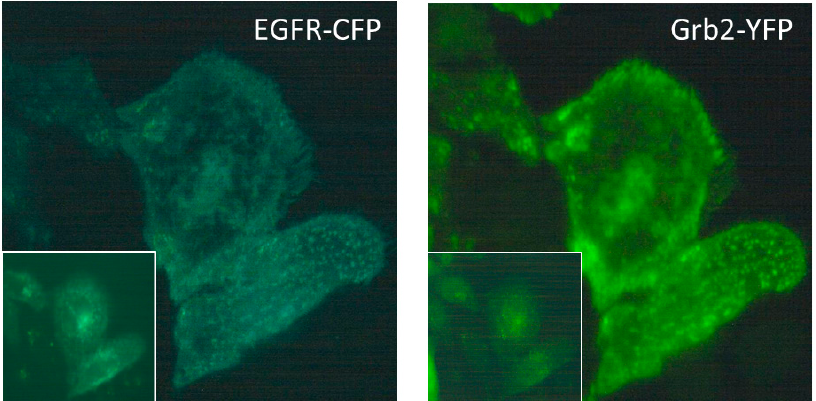
Figure 2. TIR fluorescence images of HeLa cells transfected with EGFR ‐ CFP and Grb2 ‐ YFP encoding vectors in the spectral ranges of CFP (450–490 nm) and YFP ( λ ≥ 510 nm) emission; excitation vectors in the spectral ranges of CFP (450 – 490 nm) and YFP ( λ ≥ 510 nm) emission; excitation wavelength: 420–440 nm; image size: 60 µ m × 60 µ m. Insets: fluorescence images after epi-illumination wavelength: 420 – 440 nm; image size: 60 μ m × 60 μ m. Insets: fluorescence images after epi ‐ of whole illumination of whole cells.